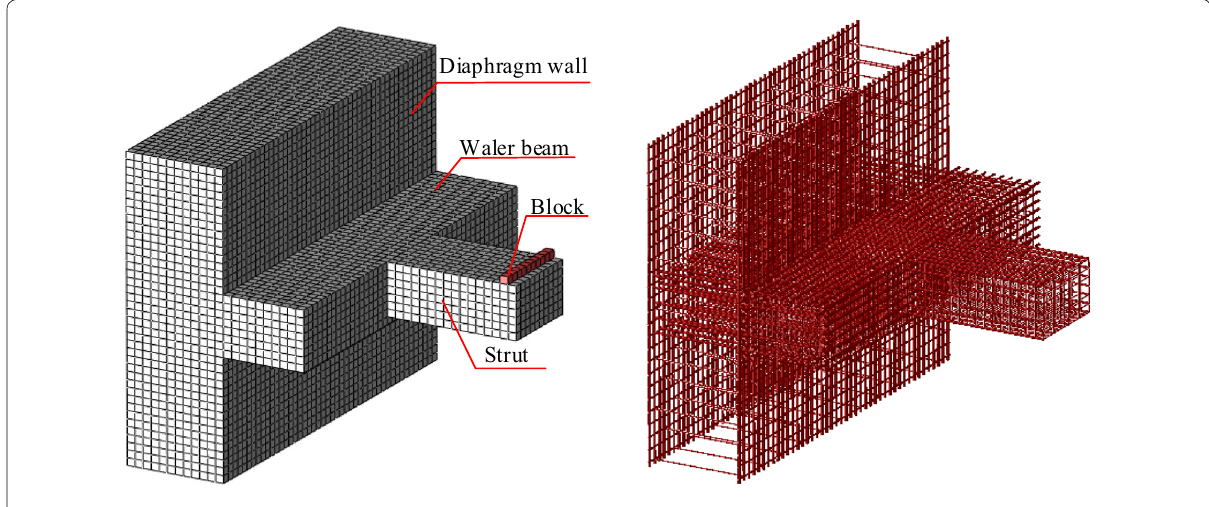
Fig. 13 Host element and embedded